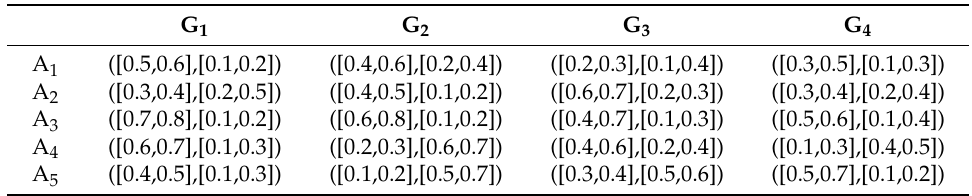
Table 1. The IVIFN decision matrix.